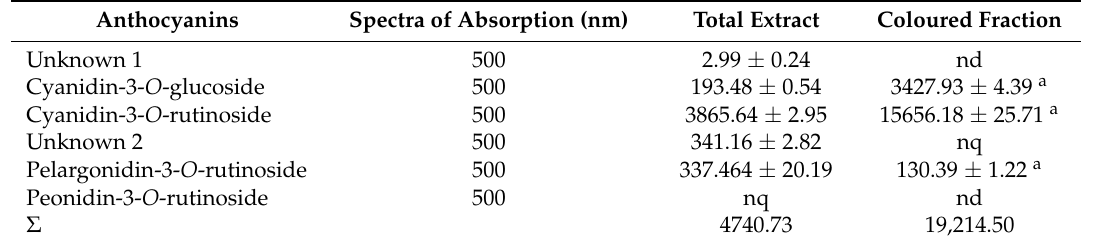
Table 2. Anthocyanin contents of Saco sweet cherry extracts ( µ g/g of dried extract). Anthocyanins Spectra of Absorption (nm) Total Extract Coloured Fraction Unknown 1 500 2.99 ± 0.24 nd Cyanidin-3- O -glucoside 500 193.48 ± 0.54 3427.93 ± 4.39 a Cyanidin-3- O -rutinoside 500 3865.64 ± 2.95 15656.18 ± 25.71 a Unknown 2 500 341.16 ± 2.82 nq Pelargonidin-3- O -rutinoside 500 337.464 ± 20.19 130.39 ± 1.22 a Peonidin-3- O -rutinoside 500 nq nd Σ 4740.73